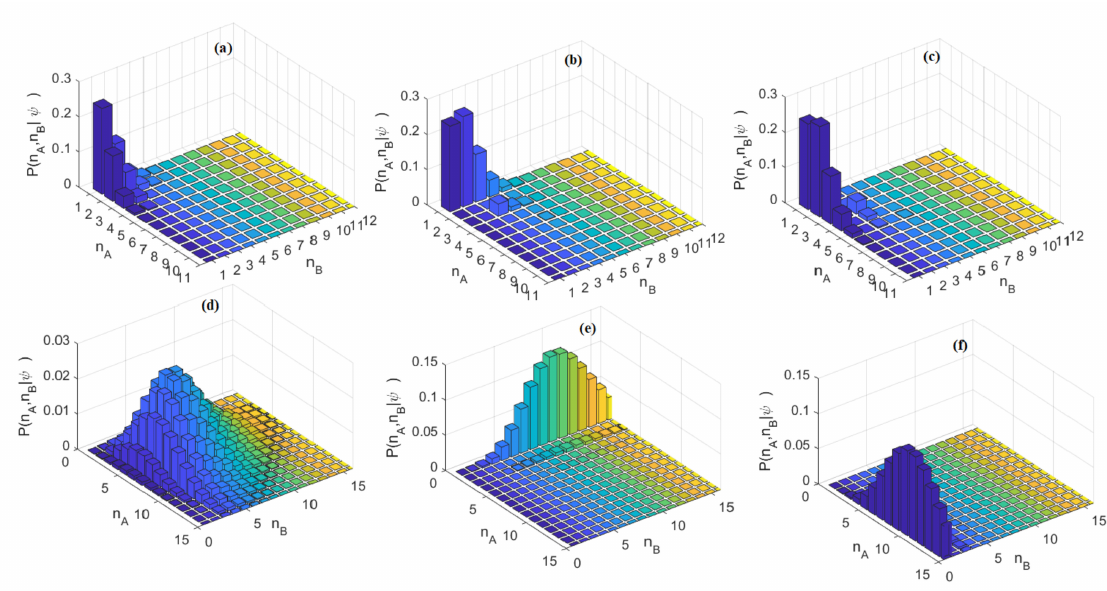
Figure 2. Probability of detecting n A photons in the mode A and n B photons in the mode B; ( a ) After BS-1, r = 0.9, n co = n sq ; ( b ) MZI output, r = 0.9, n co = n sq , ϕ = 0; ( c ) MZI output, r = 0.9, n co = n sq , ϕ = π ; ( d ) After BS-1, r = 0.3, N = 10; ( e ) MZI output, r = 0.3, N = 10, ϕ = 0; ( f ) MZI output, r = 0.3, N = 10, ϕ = π